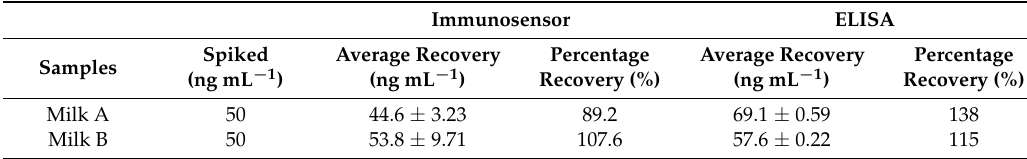
Table 2. Analysis of milk samples ( n =